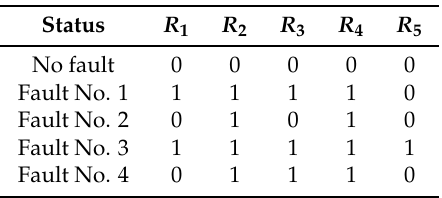
Table 2. FSM of the model-based FDI system for the SOFC plant operating in constant-voltage conditions. The binary digits from R 1 to R 5 represent the residuals of the variables listed in Table 1 after the threshold